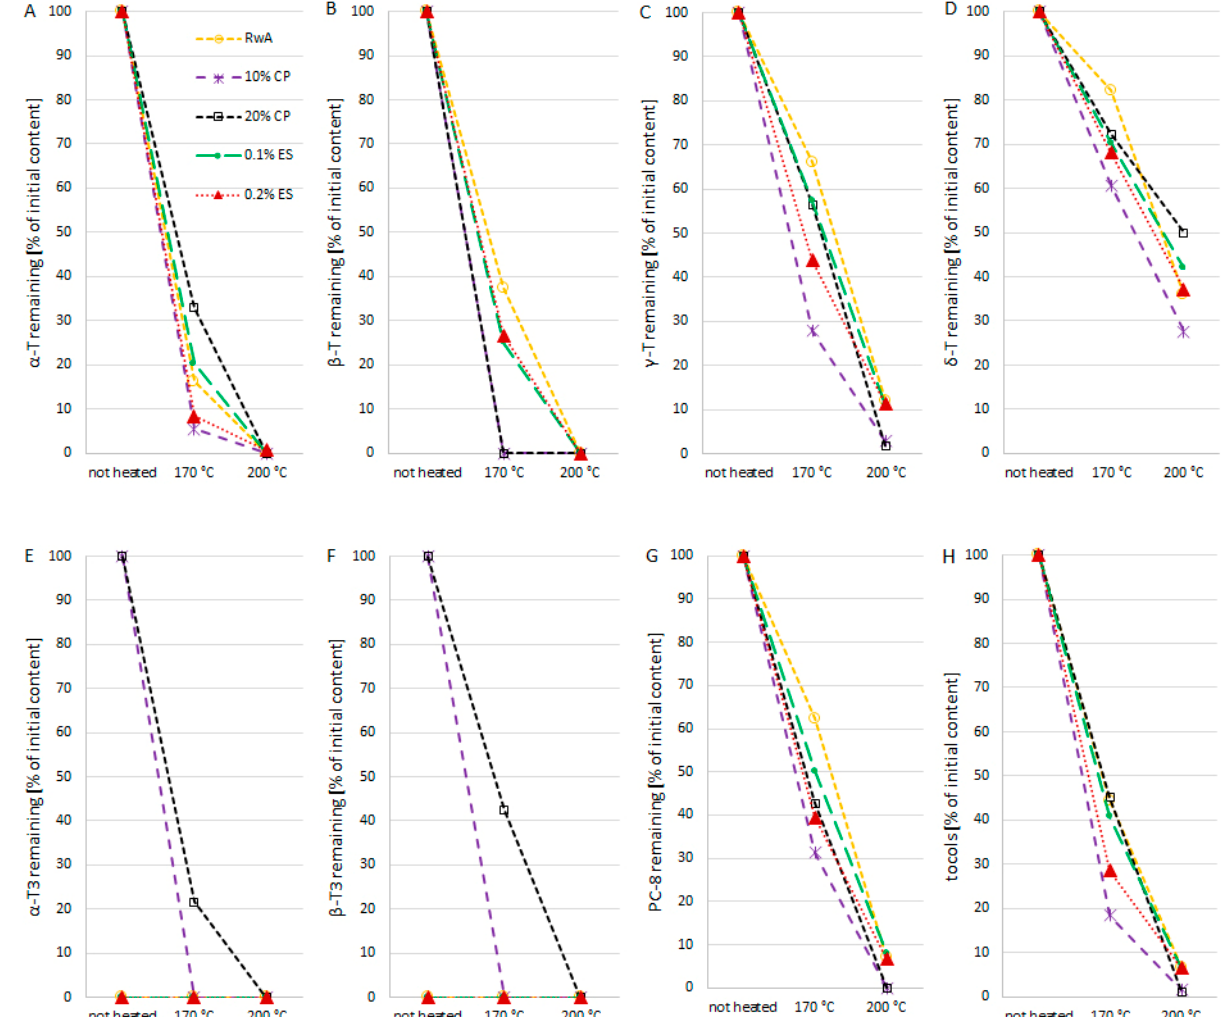
Figure 1. Changes of tocochromanols content in refined rapeseed oil and its blends during thin-layer heating at 170 and 200 °C. Values are means of four determinations. T—tocopherols ( A – D ); T3—tocotrienols ( E , F ); PC-8—plastochromanol-8 ( G ); total tocochromanols ( H ).